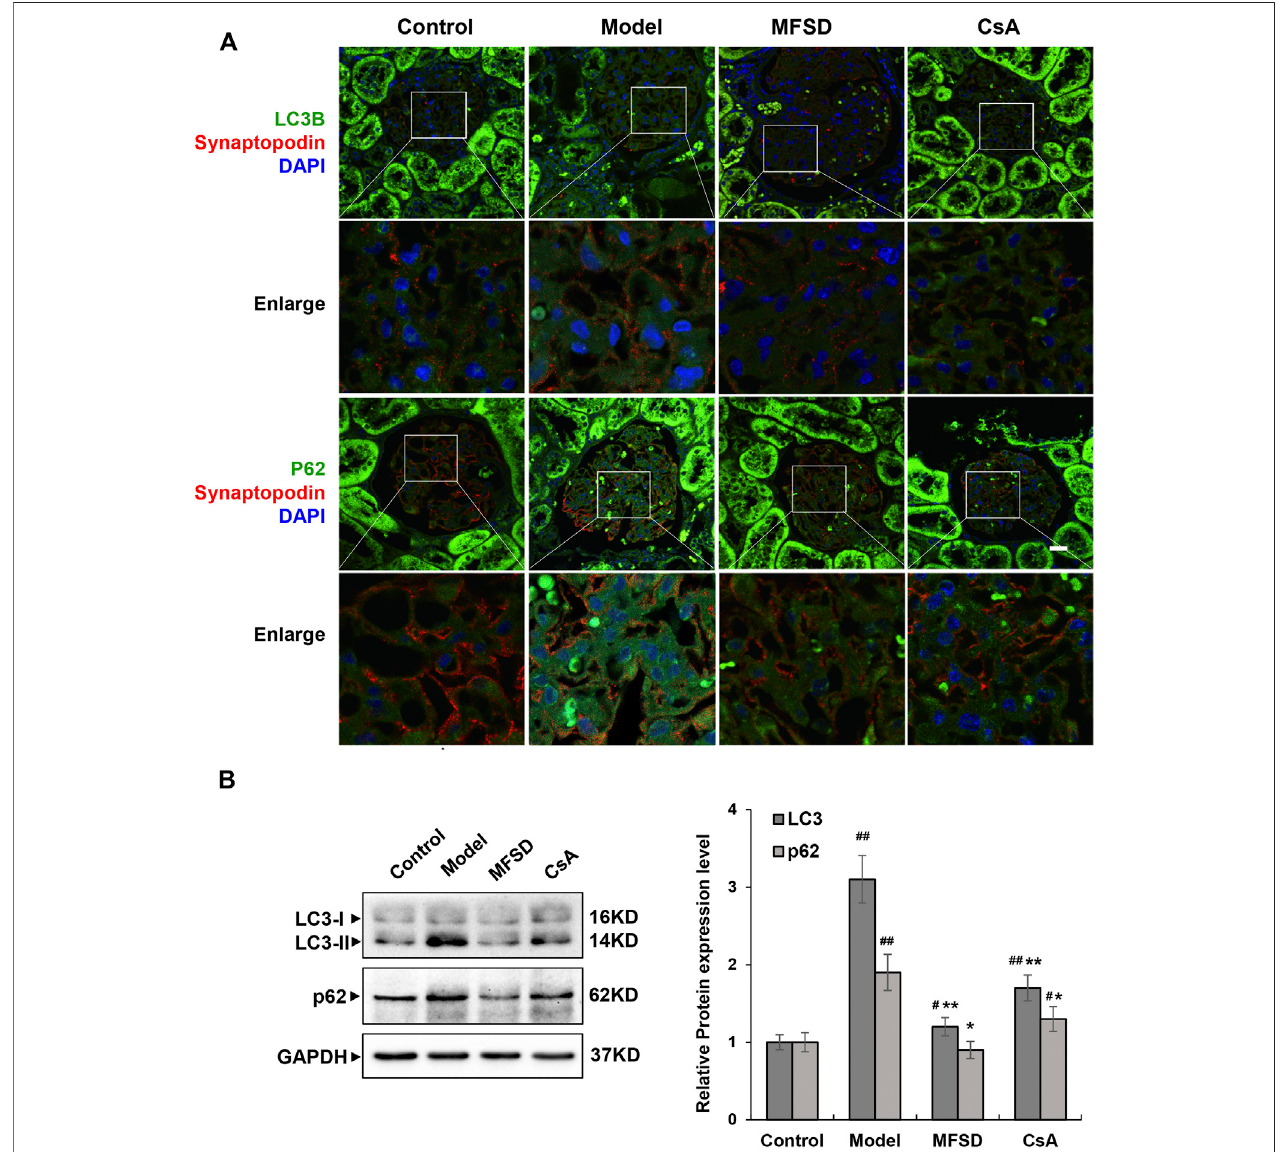
FIGURE 6 | MFSD adjusted podocyte autophagy in PHN rats (A) Immuno fl uorescent analysis of LC3B-positive puncta (green) and p62-positive puncta (green) accumulatedinpodocytes ofPHN.Thepodocytesinglomeruliwereidenti fi edbyimmuno fl uorescentdouble-labelingwithsynaptopodin (red), apodocytefootprocess- speci fi c protein. The nuclei were stained with DAPI (blue). Images were obtained using a confocal microscope. (B) The relative protein expression levels of renal LC3I/II and p62 of PHN rats were analyzed by western blot assay. The relative protein expression level was expressed as the target protein/GAPDH ratio. Values are represented as mean ± SD. # p < 0.05 and ## p < 0.01 vs . control group, * p < 0.05 and ** p < 0.01 vs . model